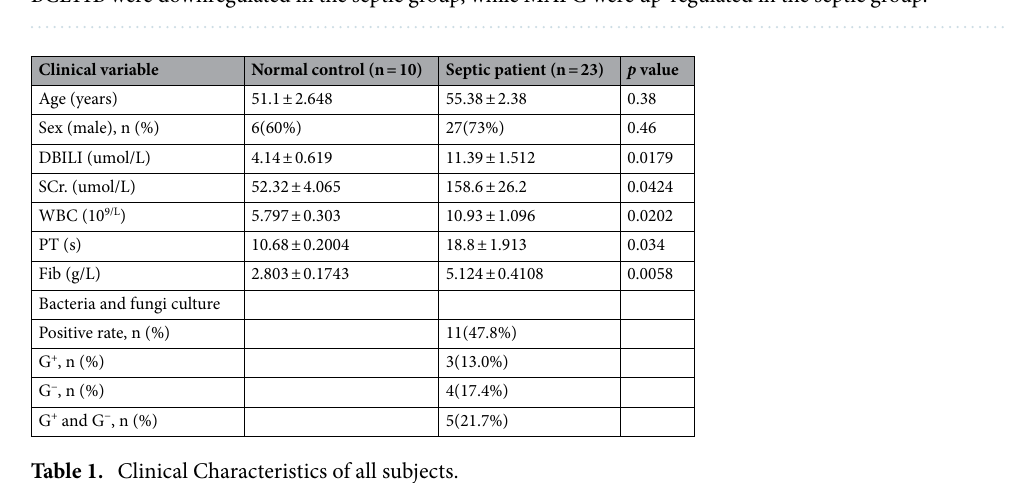
Table 1. Clinical Characteristics of all subjects.